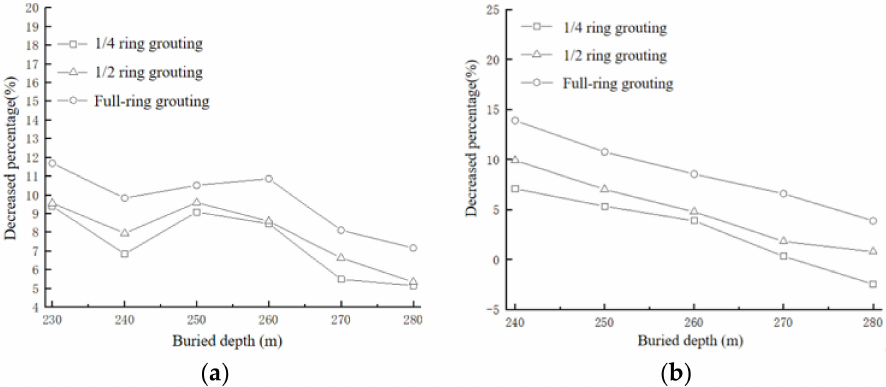
Figure 9. Decreased percentage of maximum displacement of crown settlement under different surrounding rock grades (compared with displacement limit of crown settlement). ( a ) Grade IV surrounding rock; ( b ) Grade V surrounding